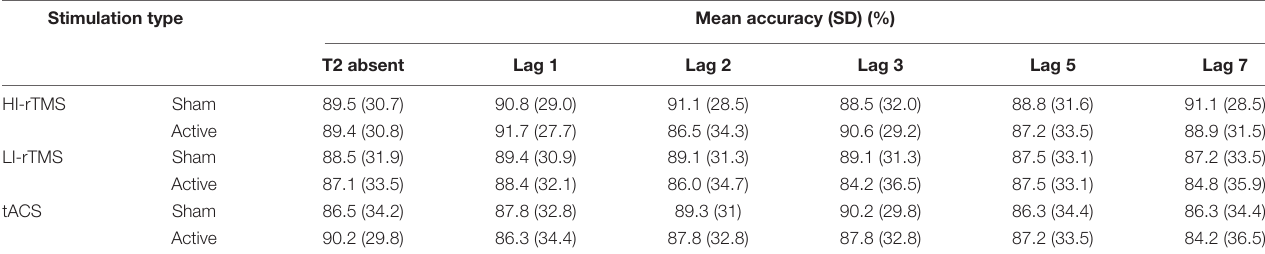
TABLE 3 | Mean accuracy (%) when responding to T1 in the attentional blink task. Stimulation type